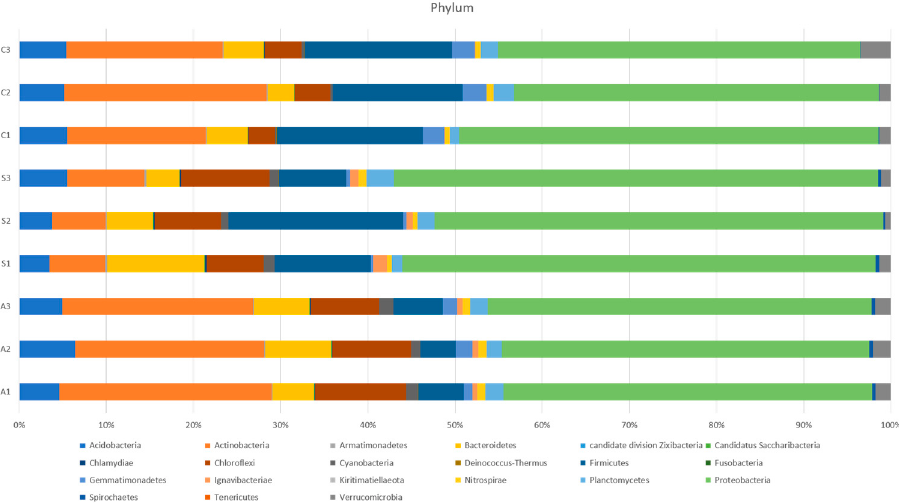
Figure 3. Taxonomic composition and relative abundance of the bacterial phylum of three different types of rice planting systems.